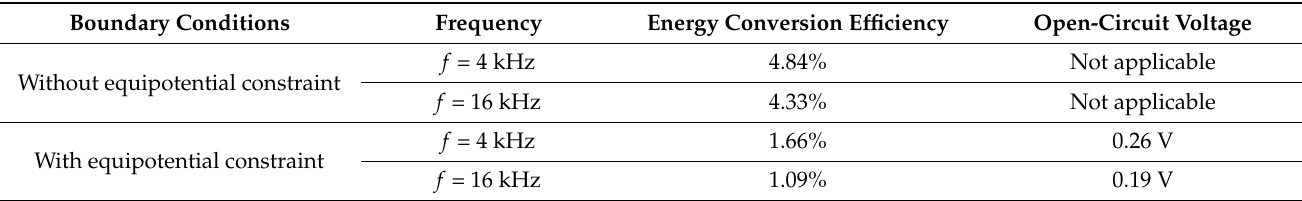
Table 1. The FEM analysis results of the energy conversion efficiency and open-circuit voltage.